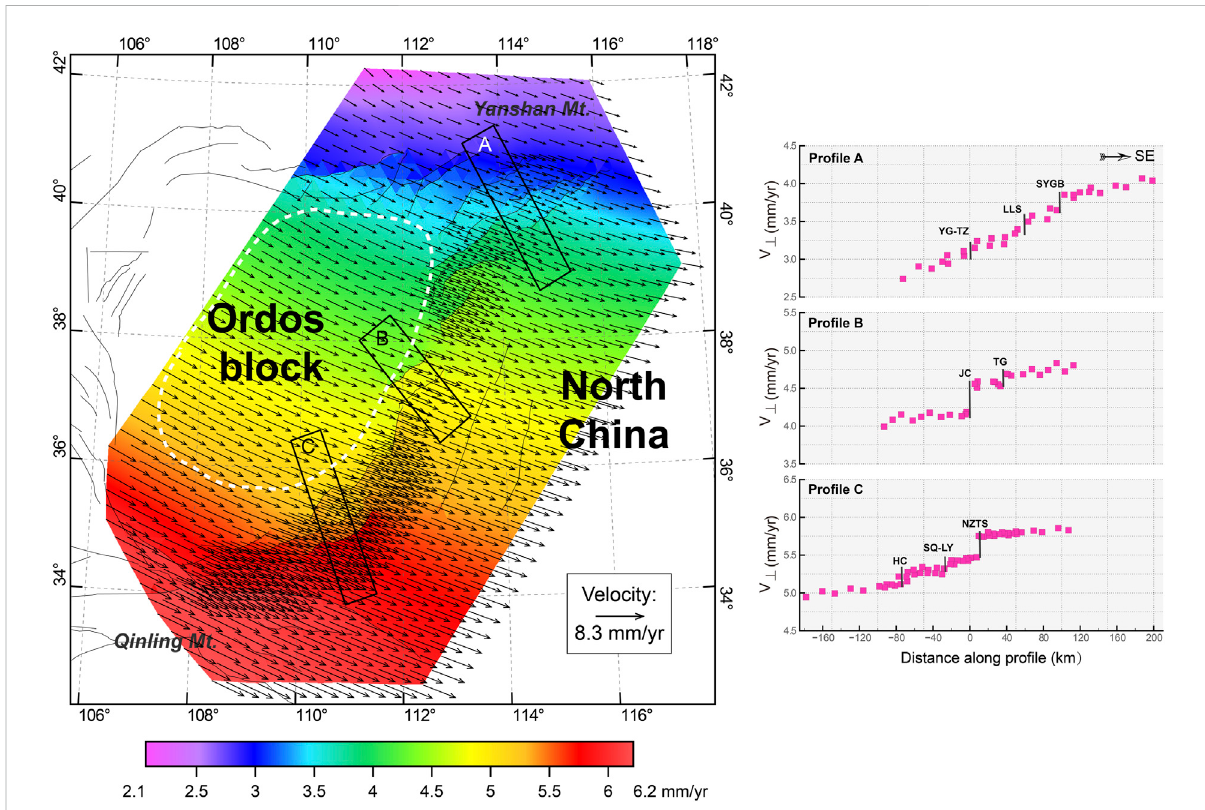
FIGURE 7 Modeled (nodal solution) long-term horizontal velocity fi eld with respect to the stable Eurasia. Pro fi les A, B, and C are three velocity pro fi les across theDatong, Taiyuan, and Yuncheng basins, respectively. The black rectangle boxes with capital lettersshow the locations of velocity pro fi les, which are plotted in the right plane. The vertical axes of the pro fi les represent the velocity component perpendicular to the trending of major active faults, so it shows the variations of horizontal extensional rate across the basin. Abbreviations of faults are given in Figure